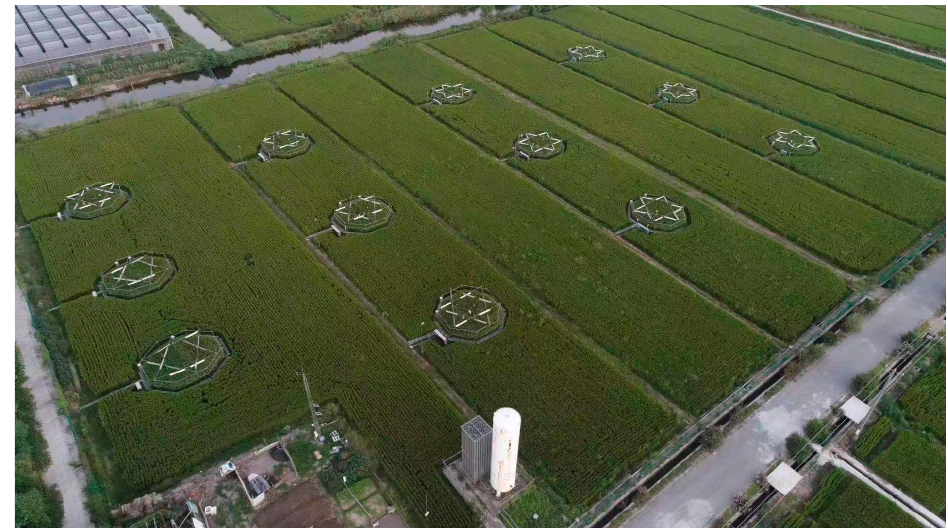
Figure 1. A photograph of the experimental set-up from the air.